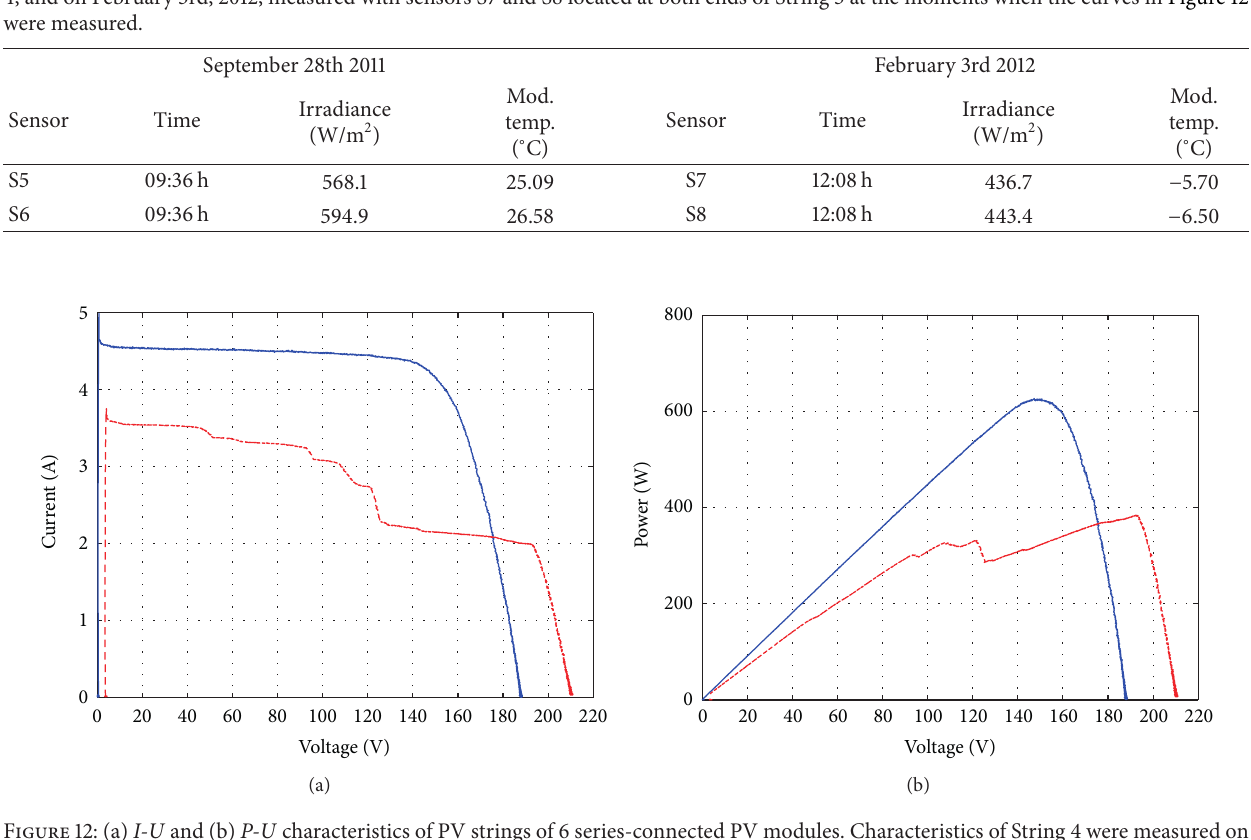
Figure 12: (a) I-U and (b) P-U characteristics of PV strings of 6 series-connected PV modules. Characteristics of String 4 were measured on September 28th, 2011, under homogeneous irradiance conditions at 09:36 (blue lines) and of String 5 on February 3rd, 2012, under partial shading conditions at 12:08 (red dashed